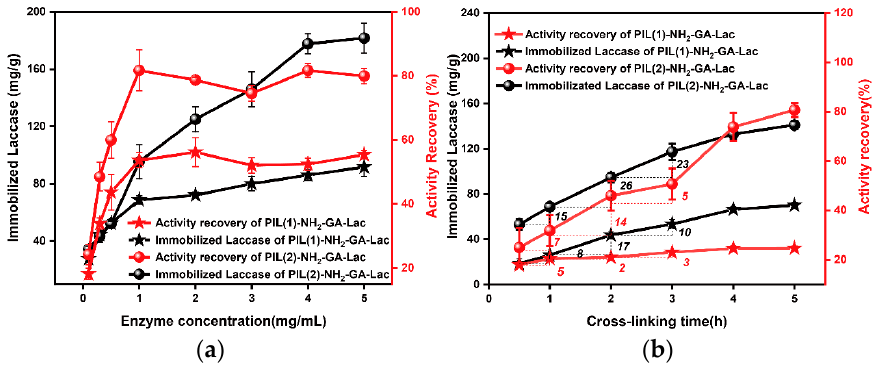
Figure 3. Effect of laccase concentration ( a ) and cross-linking time ( b ) on the activity recovery and the immobilized laccase.